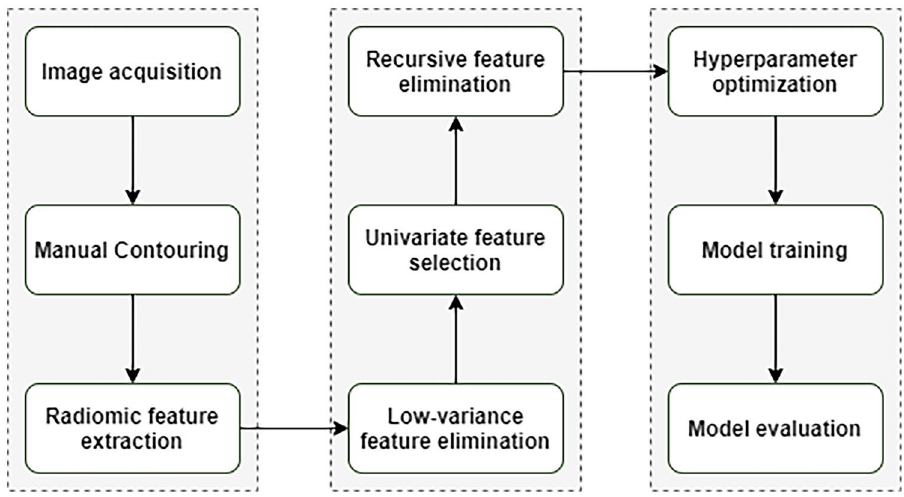
Figure 4. The pipeline for image data analysis—figure described the pipeline used to extract the imaging features as well as modeling